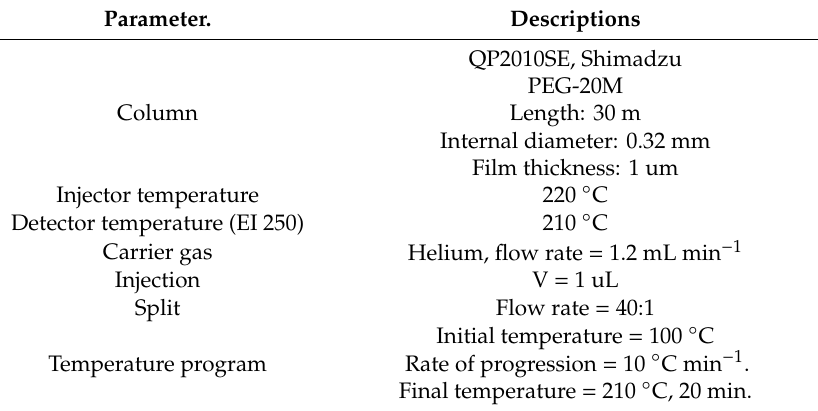
Table 1. Gas chromatograph